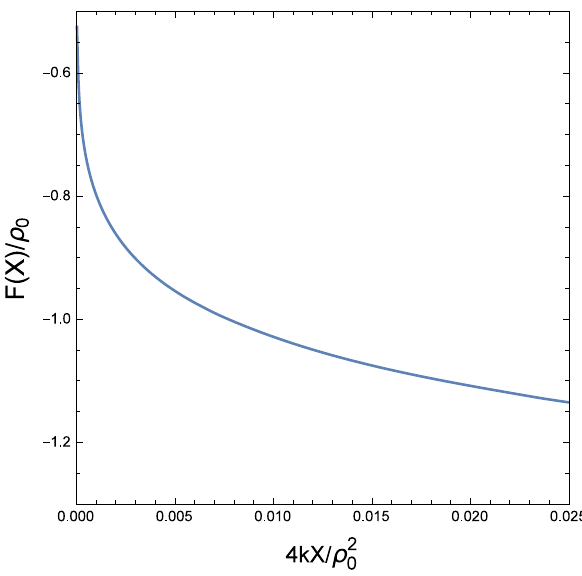
Fig. 8 Here the reconstructed F ( X ) is shown based on the parametrization w 0 + w a ln ( 1 + z /( 1 + z )) with the best fit values of w 0 ,w a obtained from the SNIa data points. The black line indicates the segment in which c 2 s >